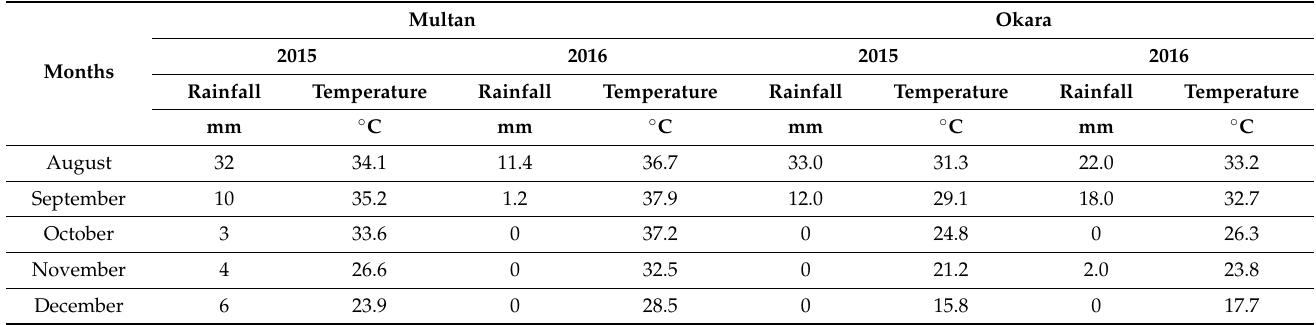
Table 1. Weather data of both study years (2015 and 2016) at Multan and Okara